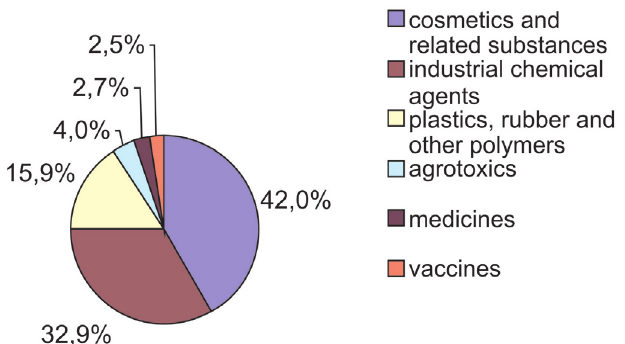
FIGURE 2 - Types of agents and respective percentage of samples submitted to acute biological assays in 602 tests conducted at Cedeme/Unifesp, from 1986 to 2000, as indicated in the previous